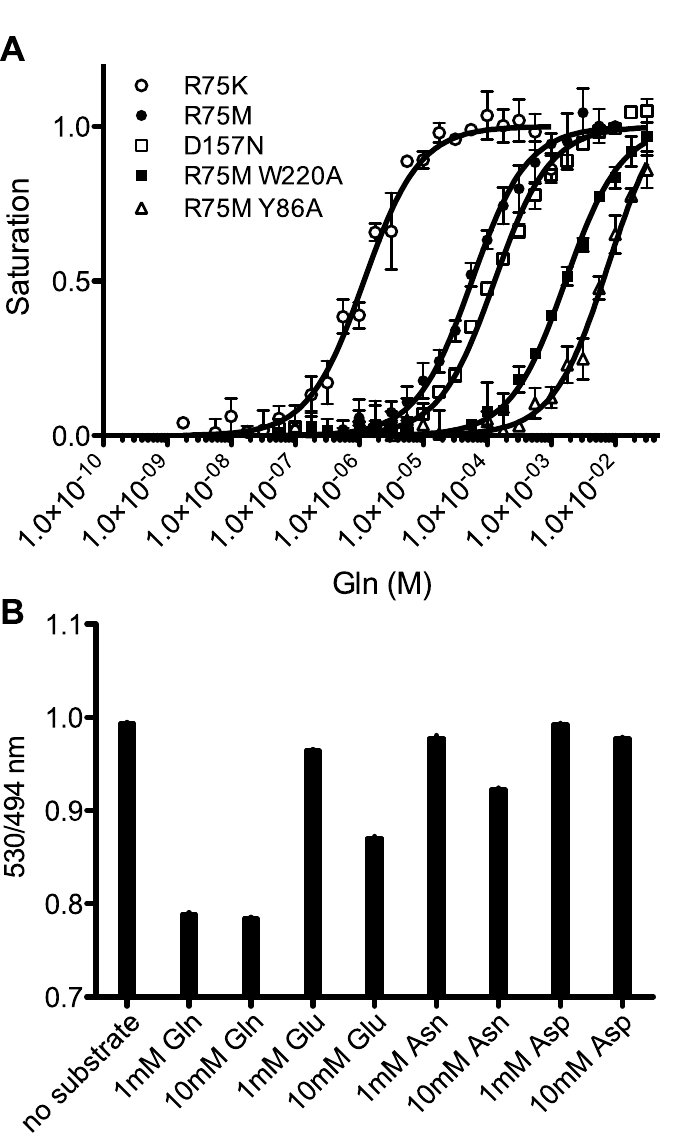
Fig 4. Affinities and substrate specificities of FLIPQ-TV3.0 sensors. (A) Saturation curves of FLIPQ-TV3.0 sensors with altered affinities. (B) Substrate specificities of FLIPQ-TV3.0_1.5 μ (black), 50 μ (hatched), 100 μ (white), 2 m (horizontal stripes), and 8 m (gray) sensors to Gln, Glu, Asn and Asp.